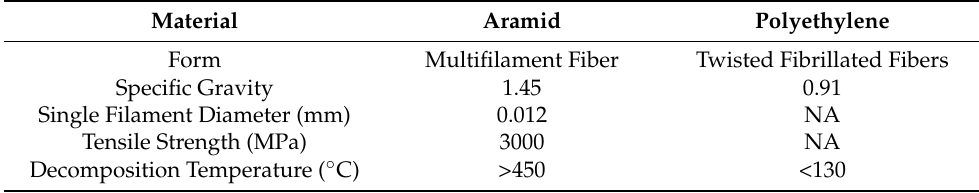
Table 2. Properties of polyethylene and aramid